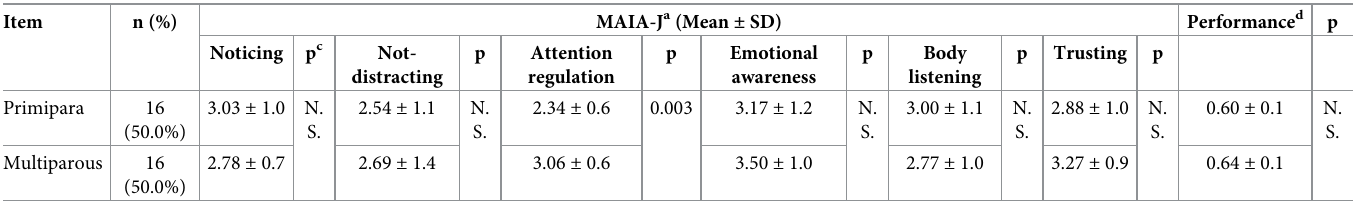
Table 3. Comparison of interoception by participants’ parity.